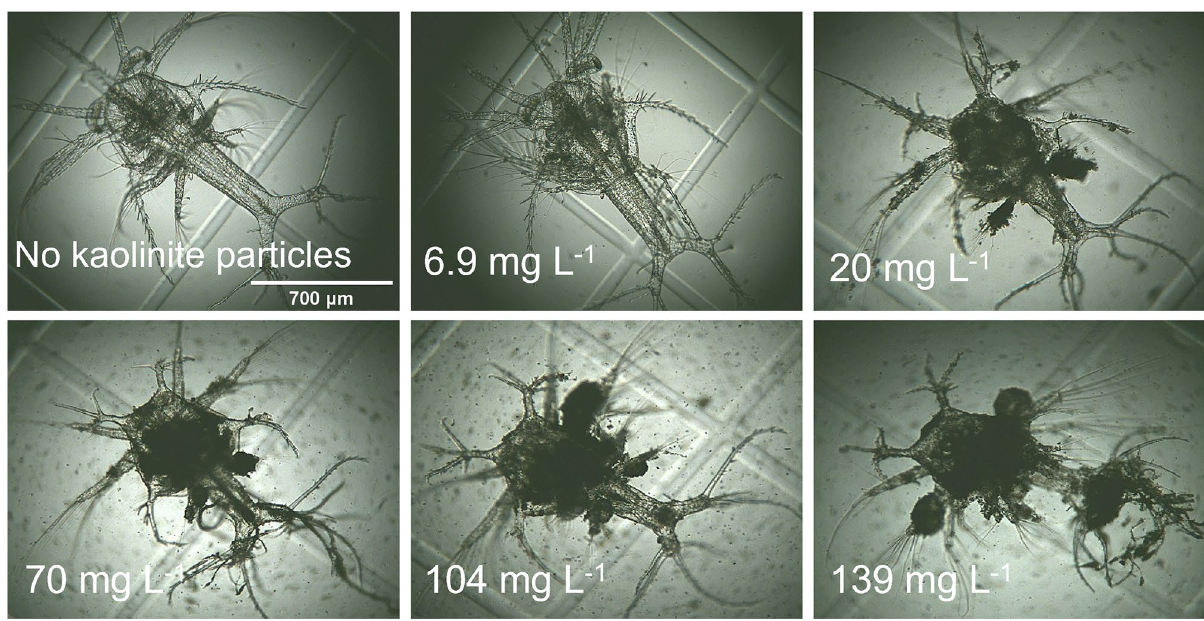
Figure 5. Appearance of elaphocaris larvae after 10 days of exposure to different suspended particle